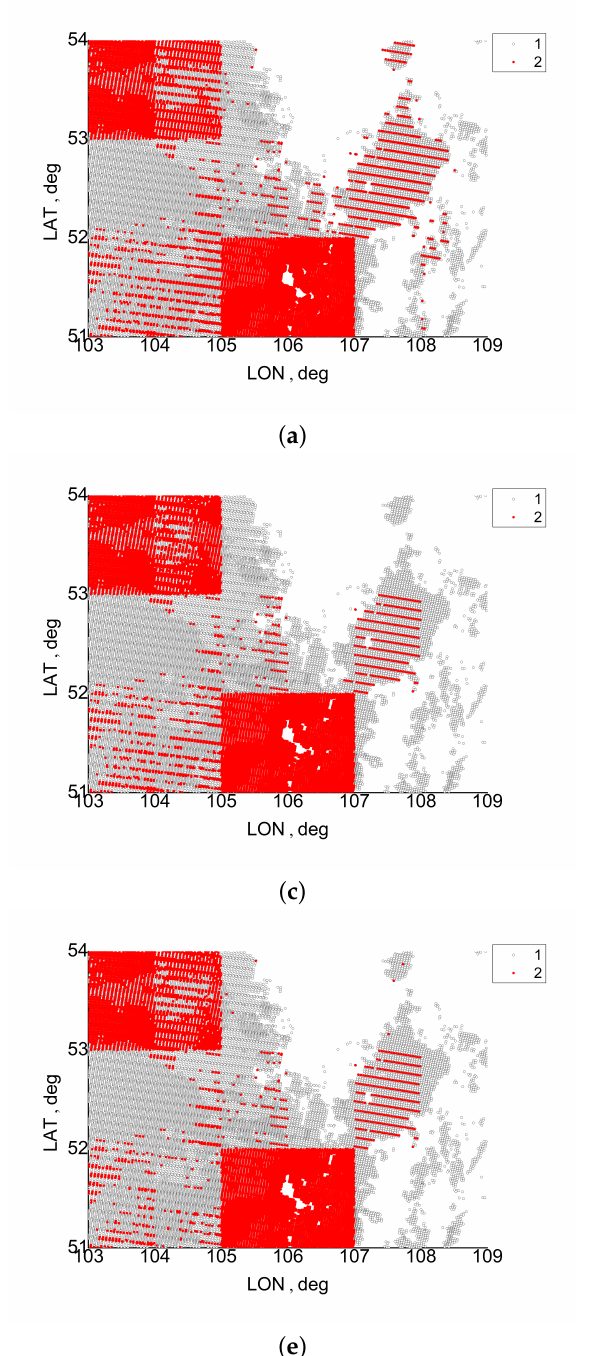
Figure 6. Masks of the cloud adjacency effect (CAE) on reflectance retrievals from MOIDS data for 03:40 UTC of 7 July 2021: ( a ) MODIS band 8, ( b ) MODIS band 3, ( c ) MODIS band 4, ( d ) MODIS band 1, ( e ) MODIS band 2; (1) cloud points, and (2) cloudless points with strong